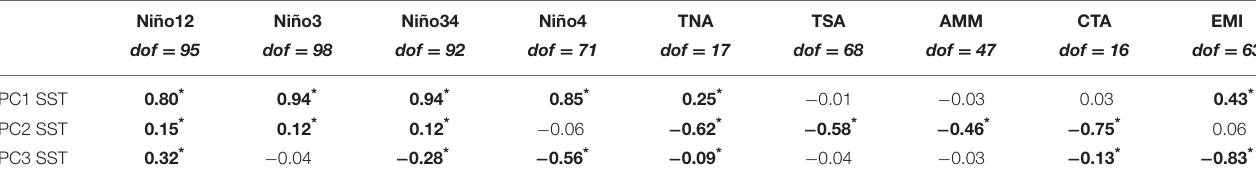
TABLE 2 | Forty-six years Cross-correlation between PCs of 4 month-lagged EOF SST × Rainfall with Pacific and Atlantic Indices. Niño12 Niño3 Niño34 Niño4 TNA TSA AMM CTA EMI dof = 95 dof = 98 dof = 92 dof = 71 dof = 17 dof = 68 dof = 47 dof = 16 dof = 63 PC1 SST 0.80 * 0.94 * 0.94 * 0.85 * 0.25 * − 0.01 − 0.03 0.03 0.43 * PC2 SST 0.15 * 0.12 * 0.12 * − 0.06 − 0.62 * − 0.58 * − 0.46 * − 0.75 * 0.06 PC3 SST 0.32 * − 0.04 − 0.28 * − 0.56 * − 0.09 * − 0.04 − 0.03 − 0.13 * − 0.83